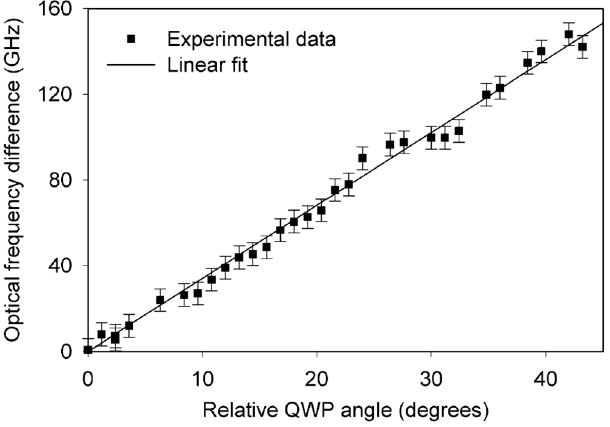
Figure 3. Tuning of the optical frequency separation between orthogonally polarized modes as a function of relative quarter-wave-plate angles [20] .